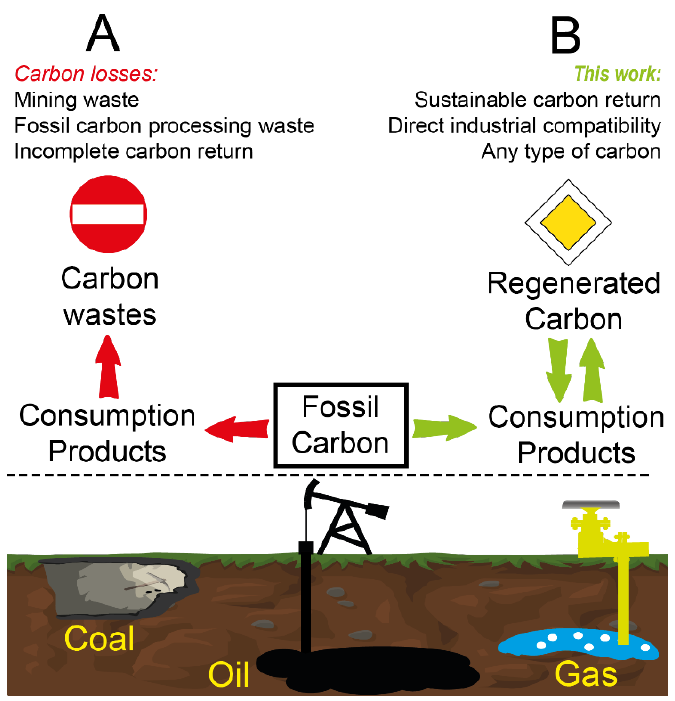
Figure 1. Carbon losses in the current route of fossil utilization ( A , red arrows) and possible improvement via the regeneration of carbon described in this article ( B , green arrows).